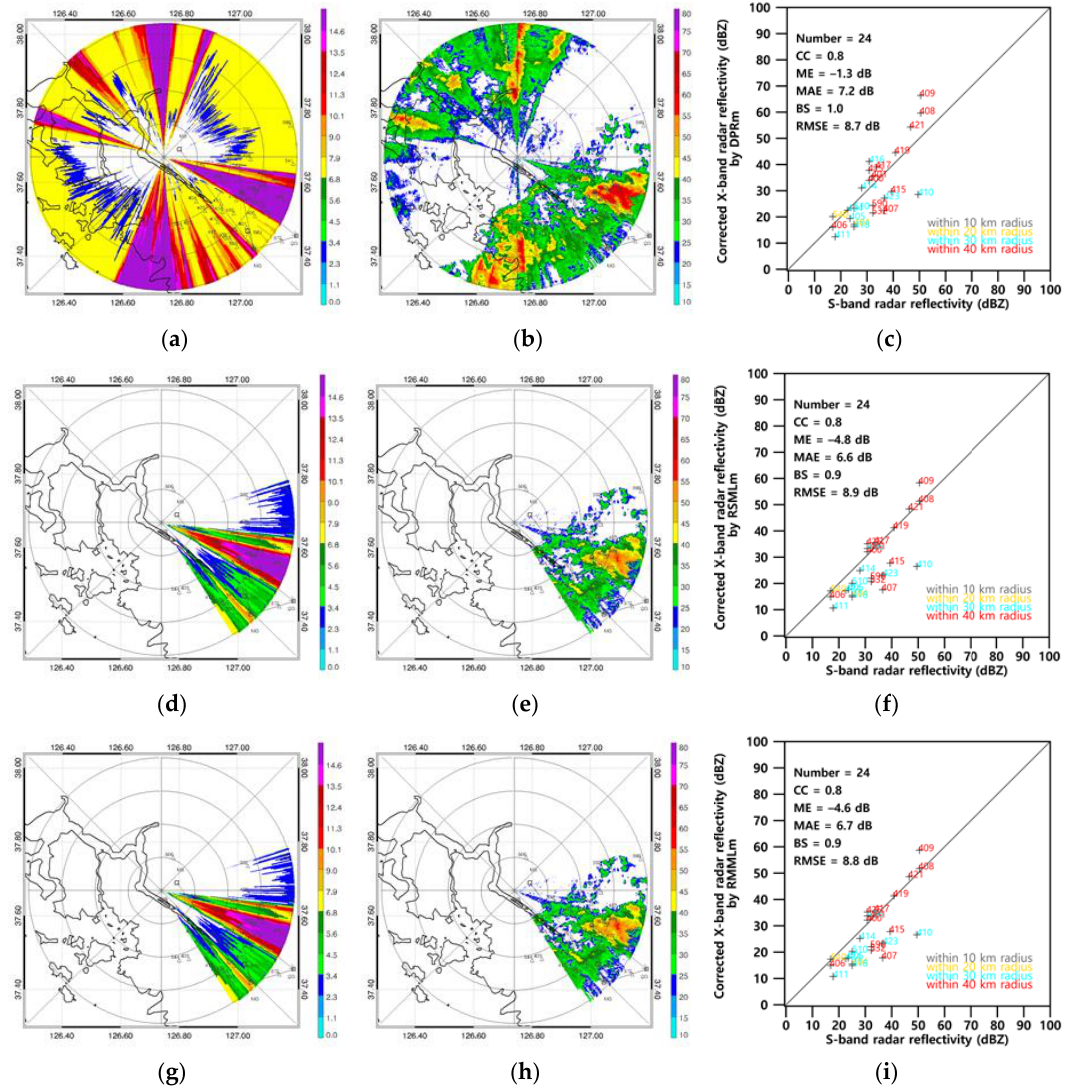
Figure 5. Radar attenuation for the convective case as estimated using the three correction methods. Their corrected reflectivity values are shown in the middle column, and comparisons between S-band radar reflectivity and corrected X-band radar reflectivity are presented in the right column. The top line represents DPRm, the middle line is the RSML method, and the bottom line is the RMML